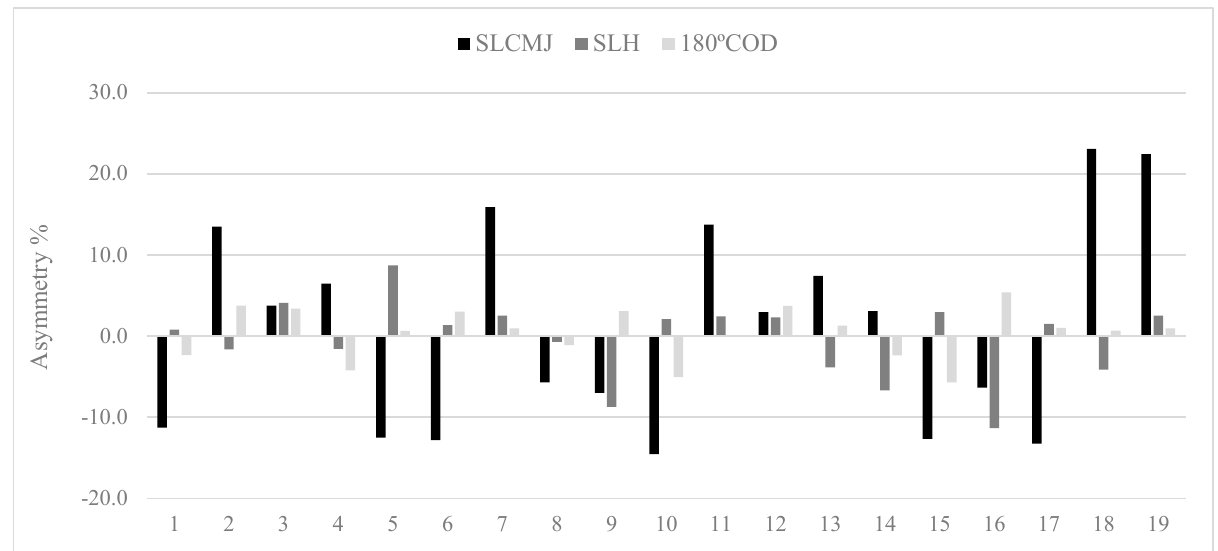
Figure 3. Data about individual asymmetry for single leg countermovement jump (SLCMJ), single leg hop (SLH) and 180° change of direction (180° COD) in the U-18 group. N.B: above 0 indicates right leg dominance and below 0 indicates left leg dominance.